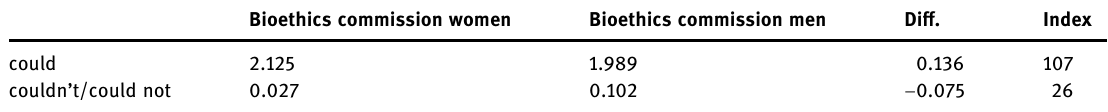
Table 26: Frequency of “ could ” and “ couldn ’ t/could not, ” as per cent of total tokens ( normalised, n = 1,000 )